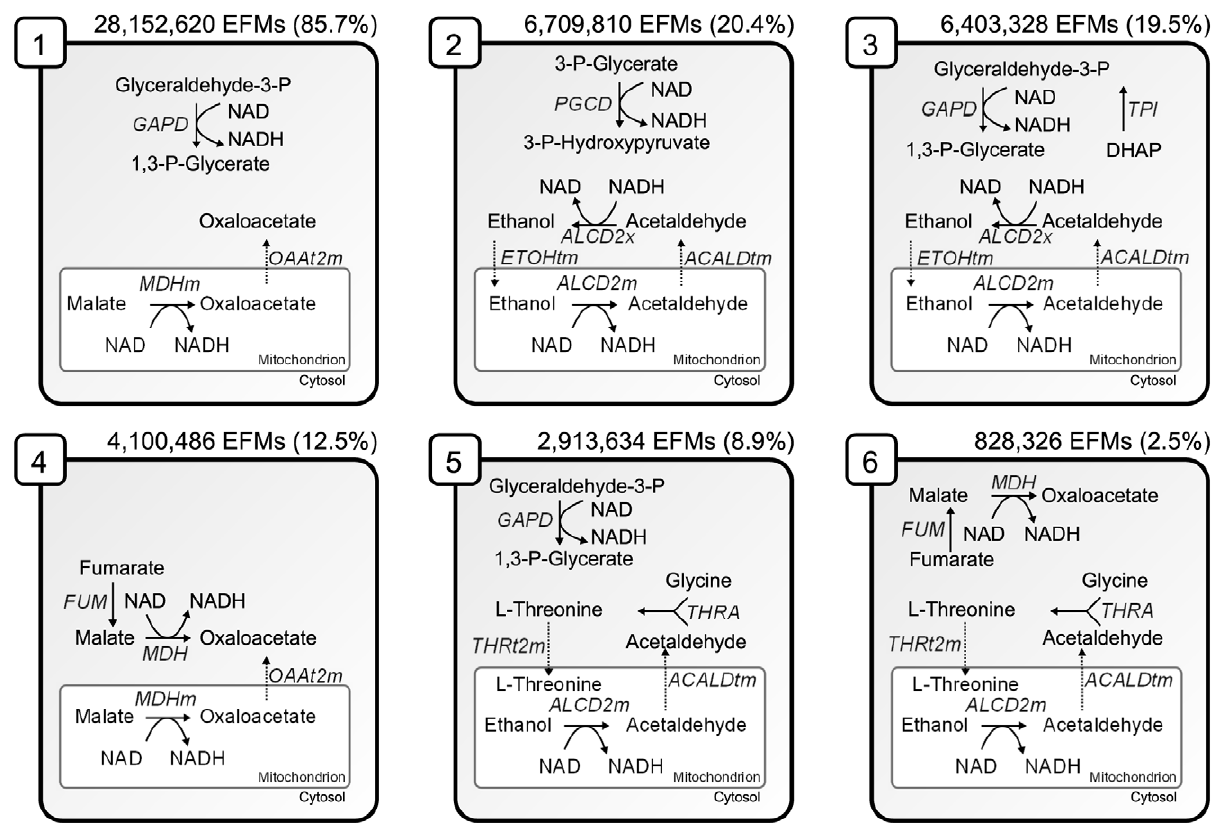
Figure 5. Overview of the six reaction patterns that cause thermodynamic infeasibility of EFMs. The number above each pattern indicates in how many EFMs the respective pattern occurs, and the number in bracket shows the percentage of the infeasible EFMs that contains the pattern.